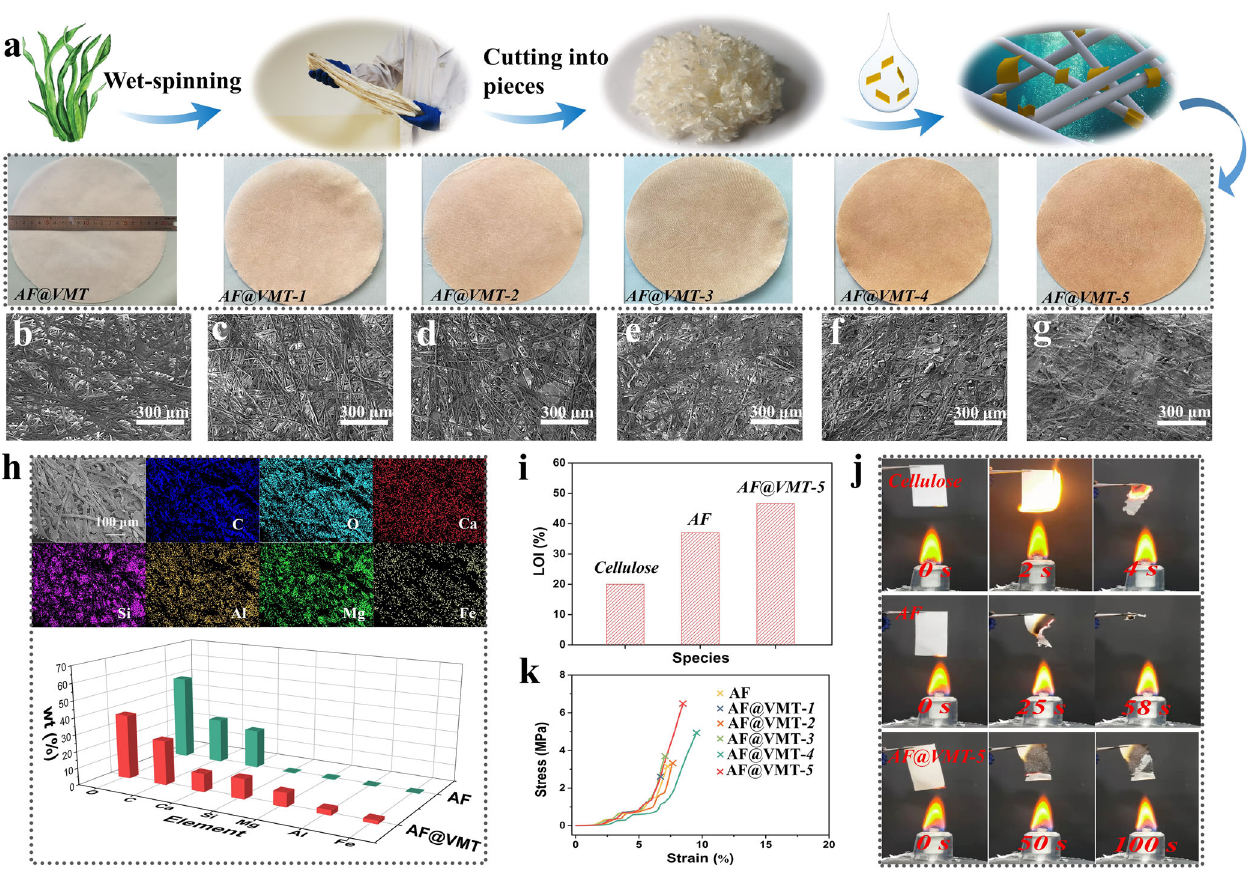
Fig. 2 Characteristics of all-natural composite paper. a Schematic diagram of the manufacture of the AF@VMT-x paper. b – g SEM images of ( b ) AF, ( c ) AF@VMT-1, ( d ) AF@VMT-2, ( e ) AF@VMT-3, ( f ) AF@VMT-4, and ( g ) AF@VMT-5 paper. h Elemental mapping images of the AF@VMT-5 paper. The graph on the right shows the weight comparison of various elements in the AF paper and AF@VMT-5 paper. ( i ) Limited oxygen indices (LOI) of different types of paper. j Photographs of the combustion process of conventional cellulose, AF and AF@VMT-5 paper during fl ame-retardant tests. k Stress – strain curves of the AF paper and AF@VMT-x